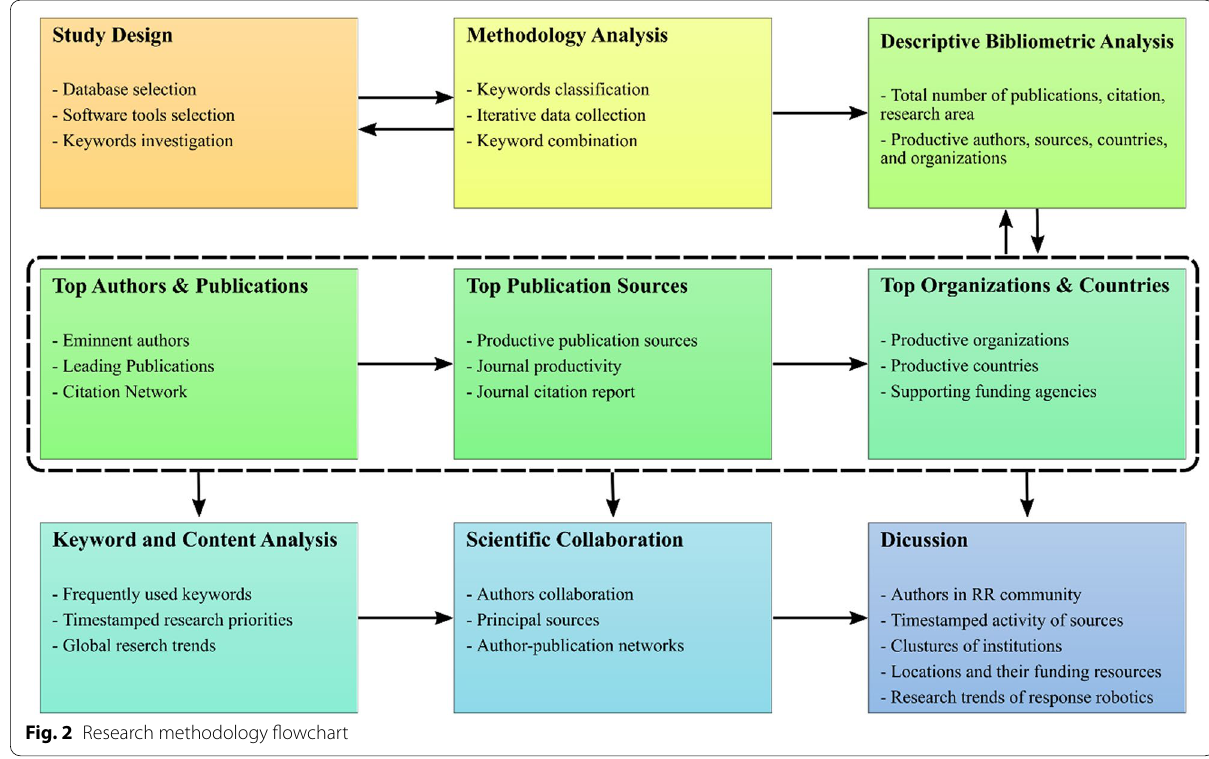
Fig. 2 Research methodology